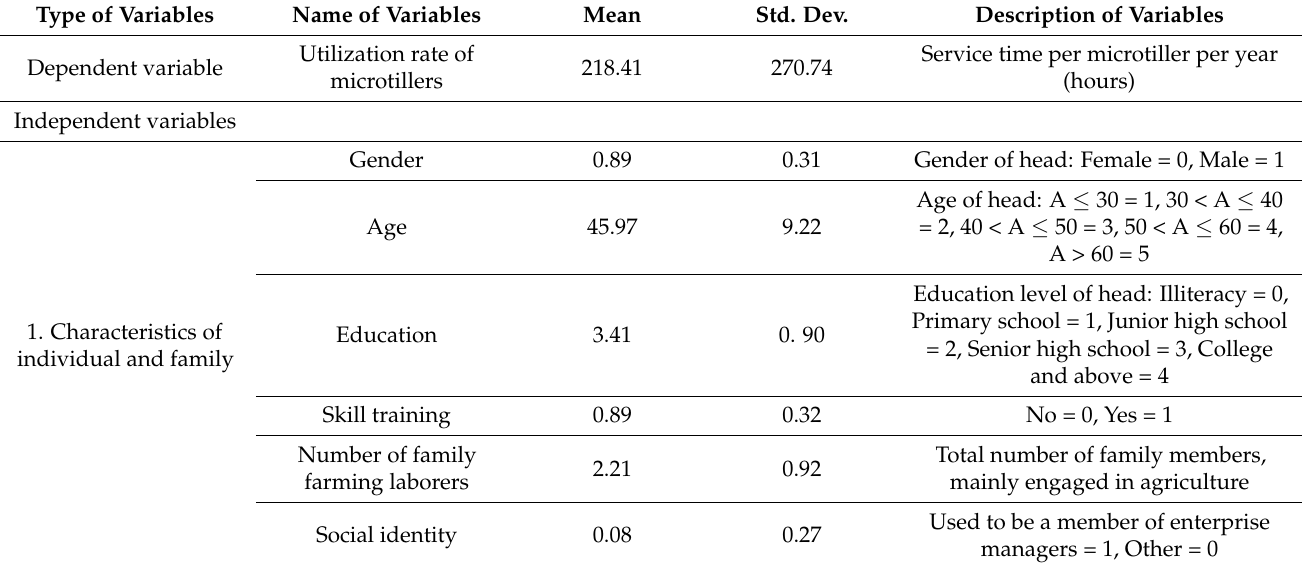
Table 1. Summary of